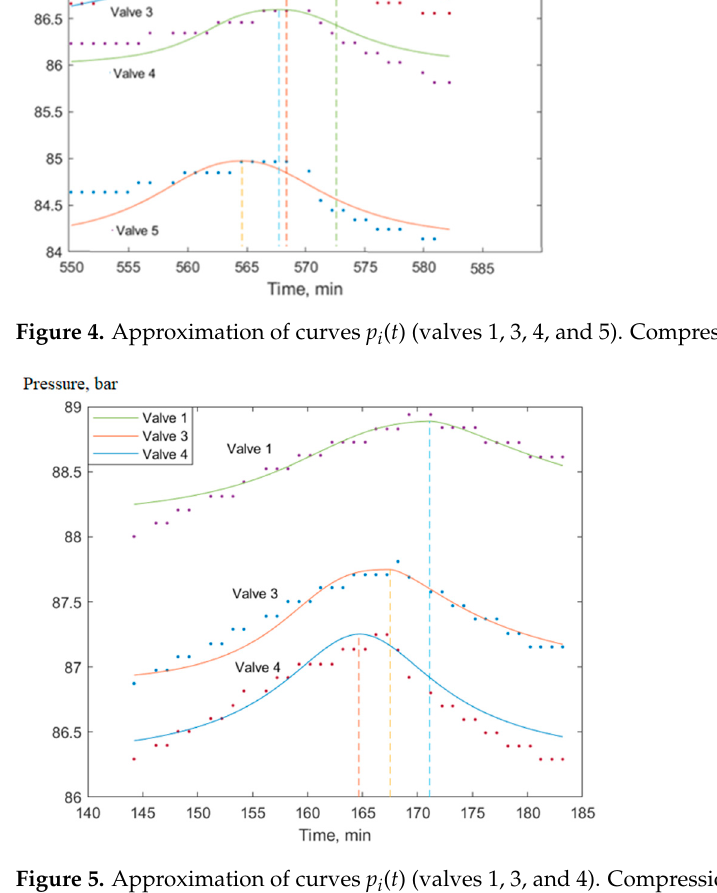
Figure 6. Approximation of curves p i ( t ) (valves 1–5). Depression waves. Example 4.